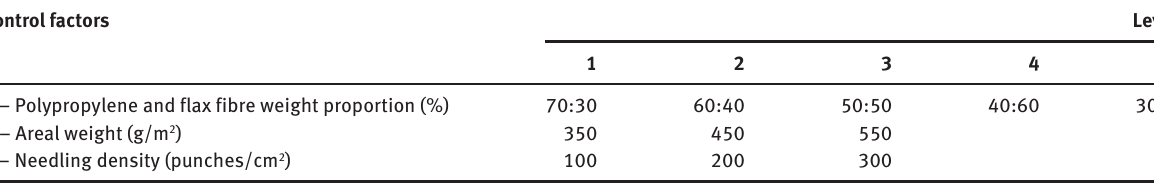
Table 2: Levels for various control factors. Control